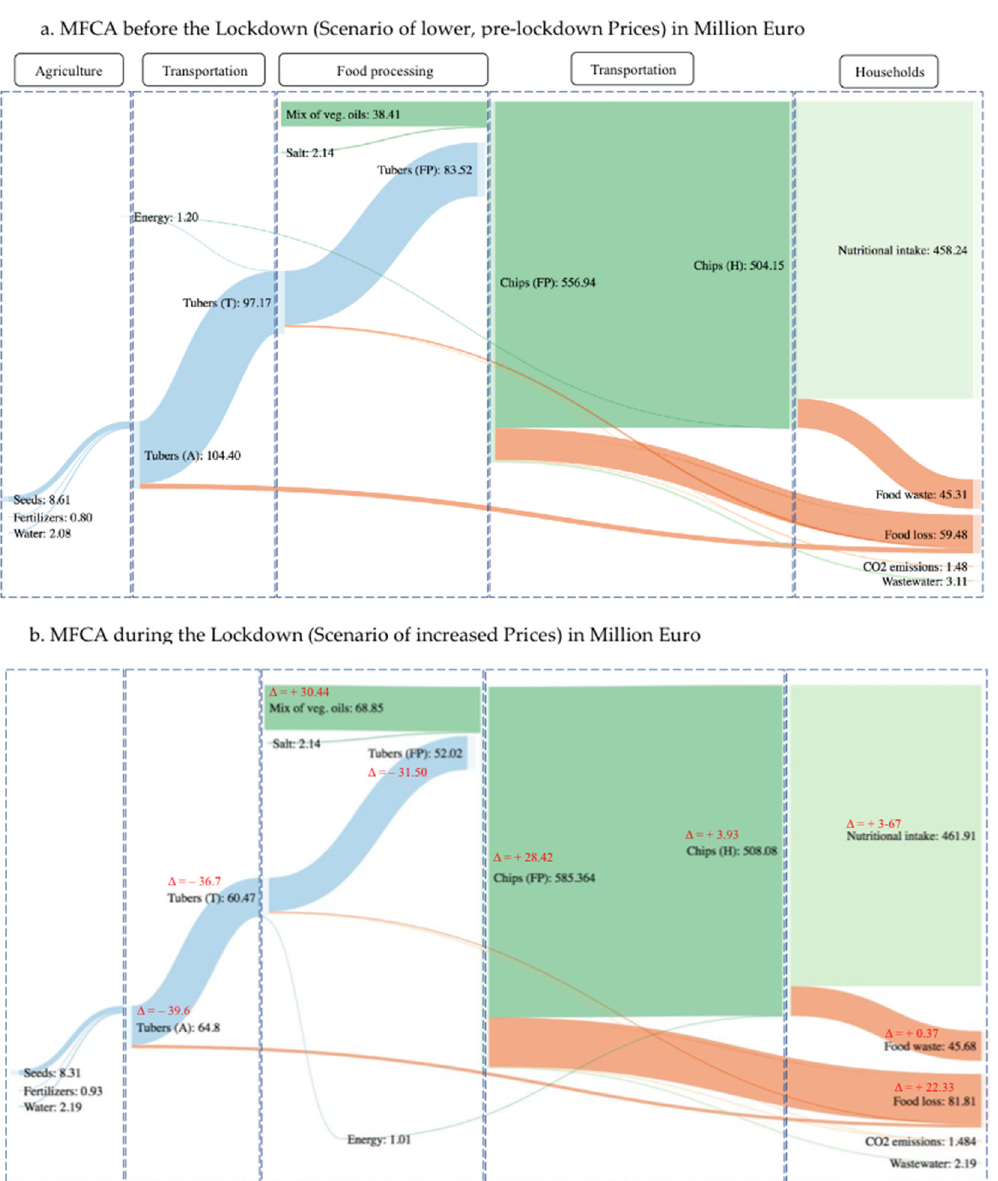
Figure 3. MFCA before ( a ) and during ( b ) the lockdown in million EUR. Notes: (A) = agriculture; (T) = transportation; (FP) = food processing; and (H) = households. Both figures identify input and output values along the entire supply chain. Figure 3b illustrates in red the variations in input and output values (e.g., Δ = –39.6 indicates a reduction in tubers costs, considering 104.40 minus 64.8 million EUR). It emerges that FLW costs have increased, respectively, by EUR +22.33 million (loss) and EUR +0.37 million (waste) during the lockdown. Source: Personal elaboration by the authors.